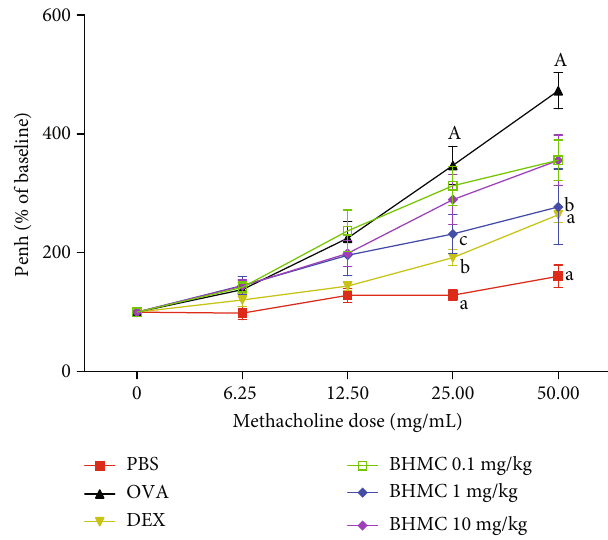
Figure 2: The e ff ect of BHMC on airway hyperresponsiveness in response to methacholine. BALB/c mice were sensitized and challenged with OVA 1 hr after treatment with DEX (3 mg/kg) or indicated doses of BHMC ( n = 8 per group). 24hrs after the last OVA challenge, the mice were exposed to incremental doses of methacholine (6.25, 12.5, 25, and 50mg/mL) in an enclosed chamber for 3min, and the readings were recorded for 5 min after each nebulization. The values are expressed as mean ± SEM . c: P < 0 : 05 , b: P < 0 : 01 , and a: P < 0 : 005 , signi fi cantly di ff erent from the OVA group. A: P < 0 : 005 , signi fi cantly di ff erent from the PBS